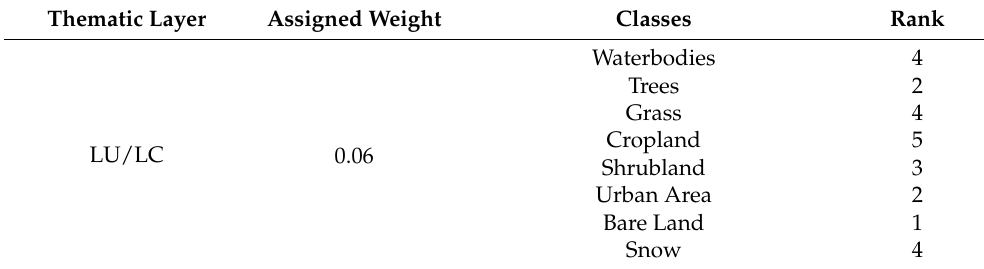
Table 5. Cont. Thematic